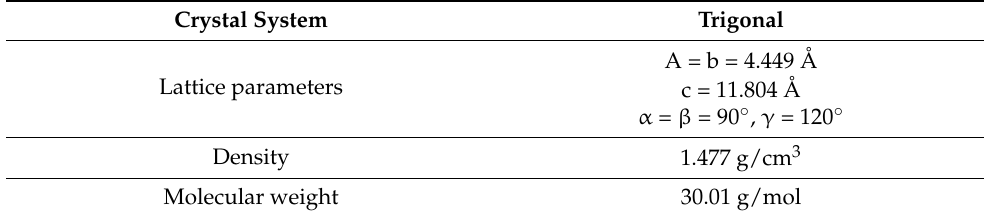
Table 1. Crystallographic data of α (cid:3398) AlH (cid:2871) [28]. Cited from Ref. [28] with permission. Table 1. Cont.